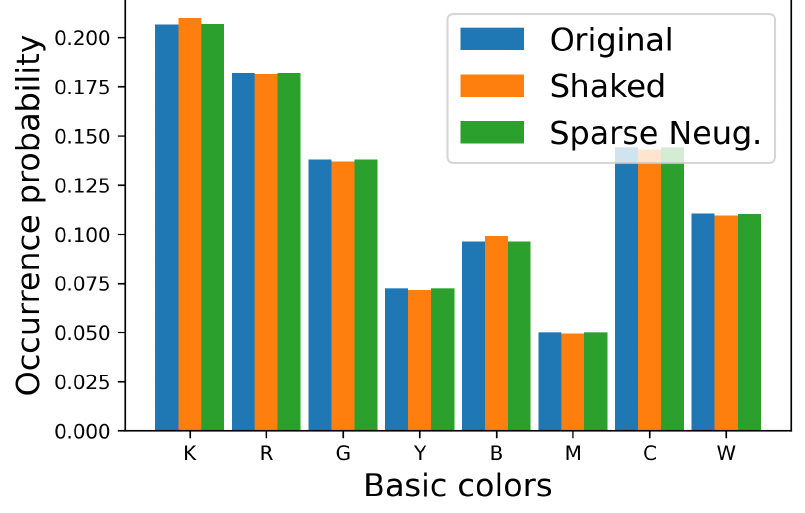
Figure 13. Occurrence probabilities of basic colors.